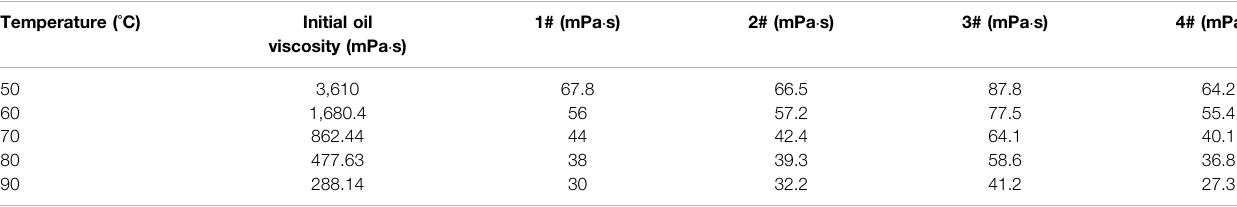
TABLE 3 | Experimental data on viscosity reduction effect. Temperature ( ° C)